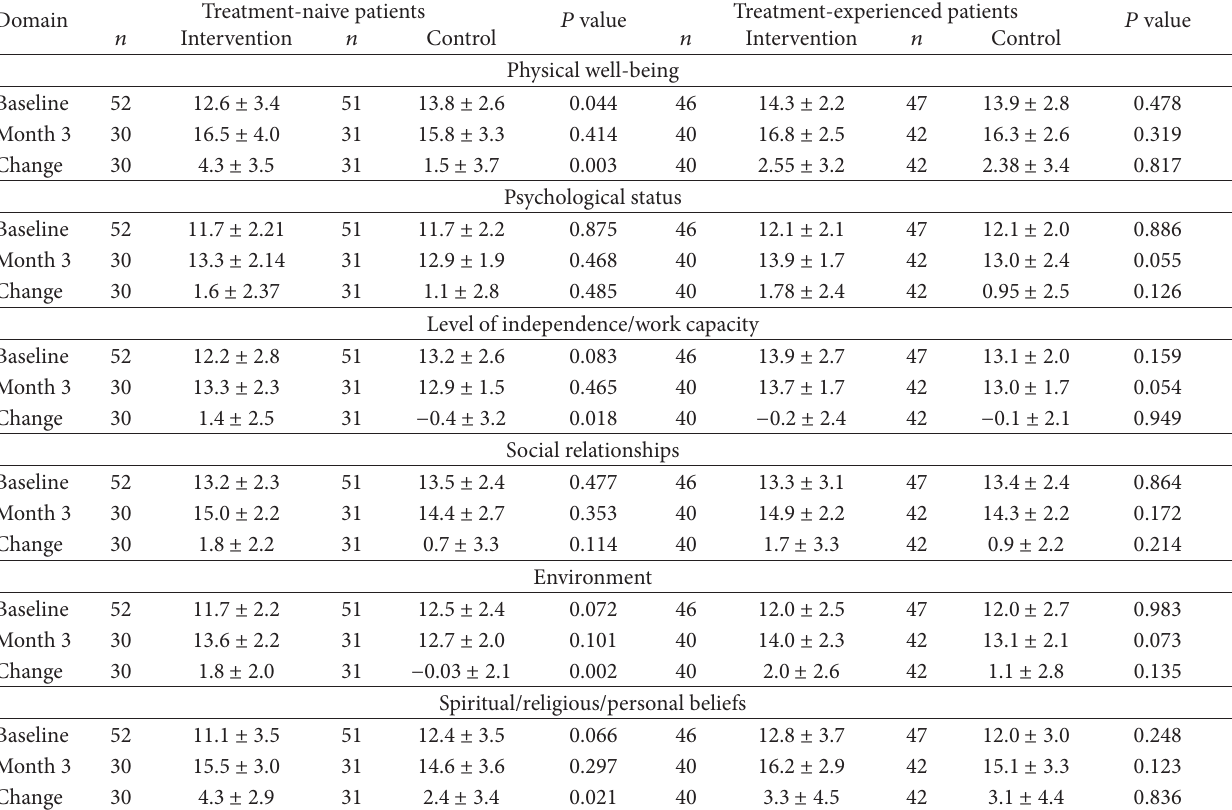
T 4: Comparison of quality of life domains and change (mean, SD) from baseline to month 3 between intervention and control groups. Treatment-naive